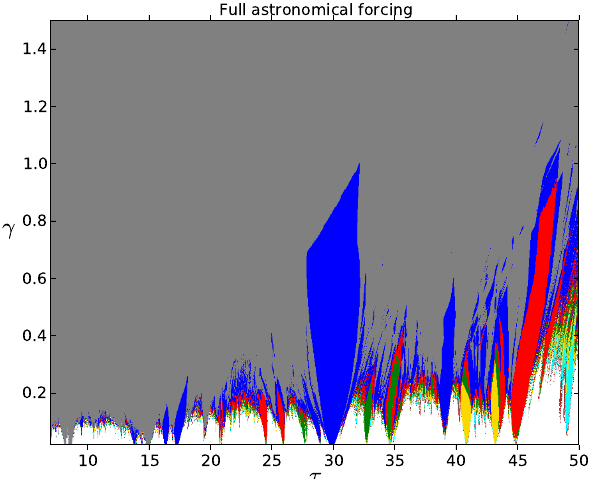
Fig. 13. As Fig. 8 but with the full astronomical forcing, made of 34 precession and 34 obliquity periods (Eq. 2).